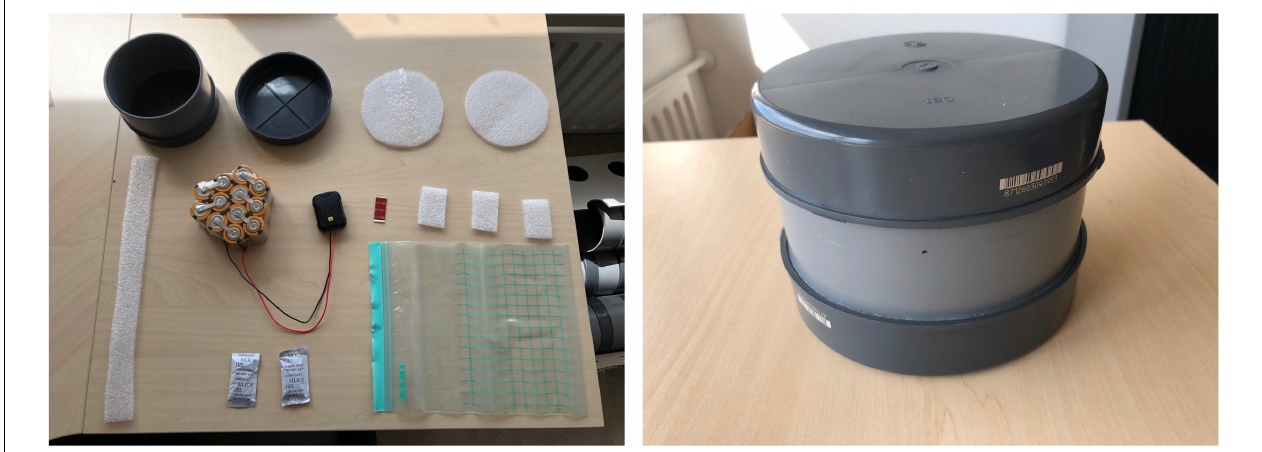
FIGURE 1 | Photos of the Stokes drifters, in their unassembled components (left) and once assembled (right) . The Stokes drifters were built from a 10-cm long piece of PVC pipe, with two caps. Each contained a GlobalStar SPOT TRACE tracker with GPS receiver powered by 12 D-cells. Photos by Daan Reijnders.